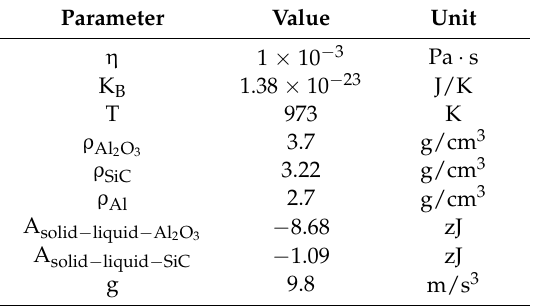
Figure 6. ( a ) Transmission electron microscopy (TEM) bright-field image and ( b ) TEM dark-field image of the dispersion of SiC np and Al 2 O 3np in Al 2 O 3np /SiC np /Al. ( c , d ) are high-resolution transmission electron microscopy (HRTEM) images of the interface between SiC np and Al 2 O 3np and Al in Al 2 O 3np /SiC np /Al, respectively. The insets in ( c , d ) are the fast Fourier transformation (FFT) of nanoparticles. Table 2. Parameters used for calculations of critical velocity in Al 2 O 3np /SiC np /Al alloy [21,34].